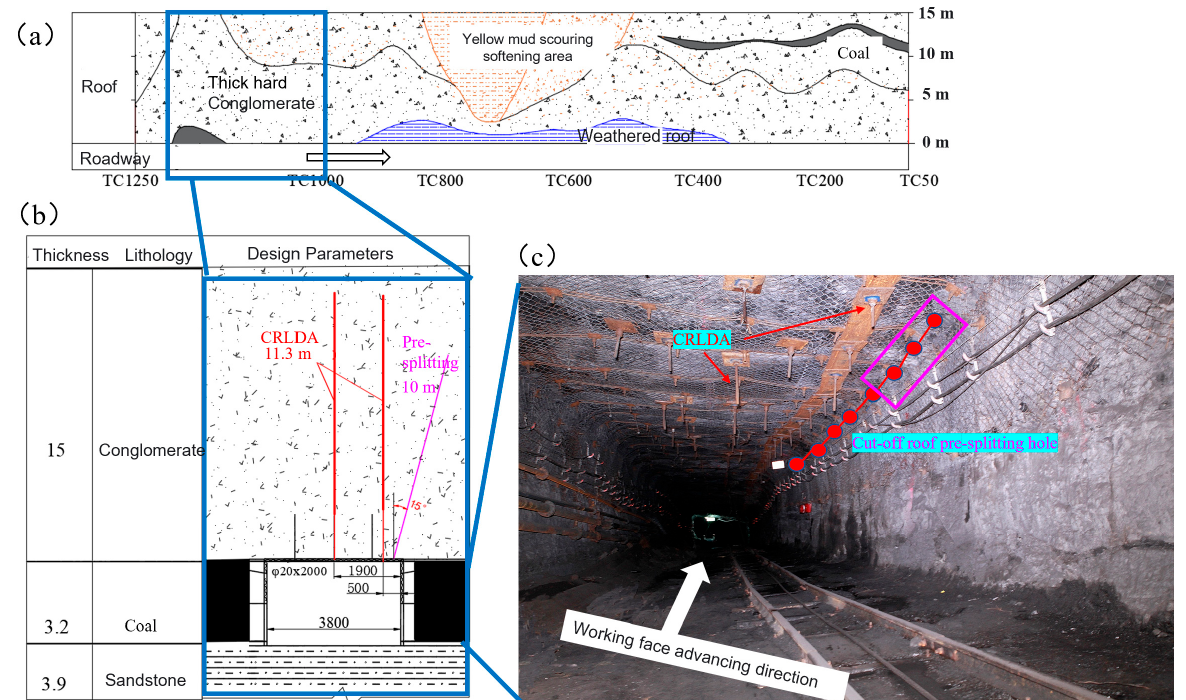
Figure 7. Non-pillar mining design parameters and site construction ( a ) The roof lithology profile ( b ) Design parameters ( c ) Construction site picture according to design parameters.